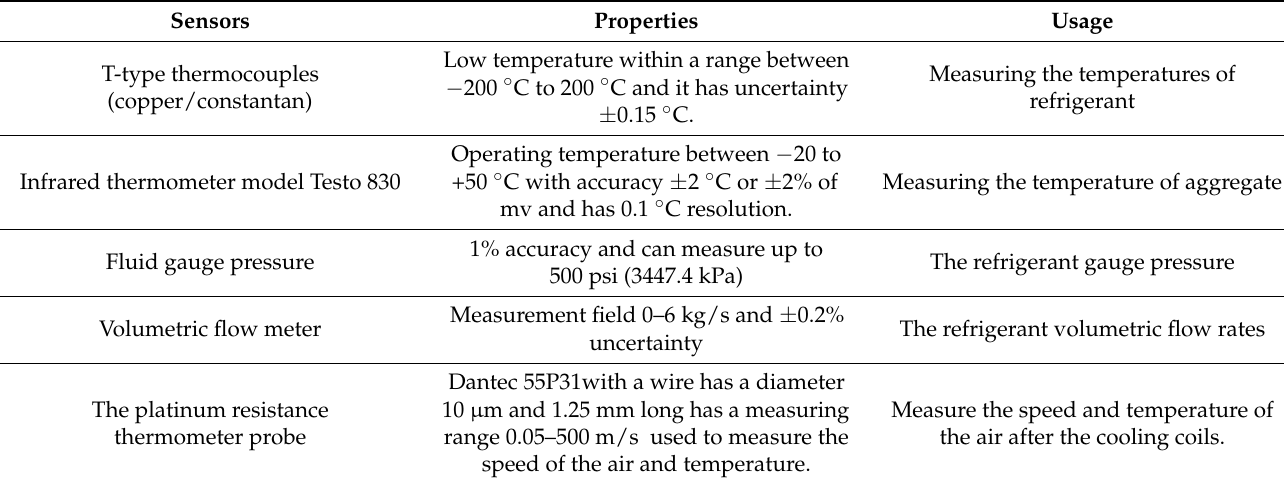
Table 4. List of sensors used in the experiment.